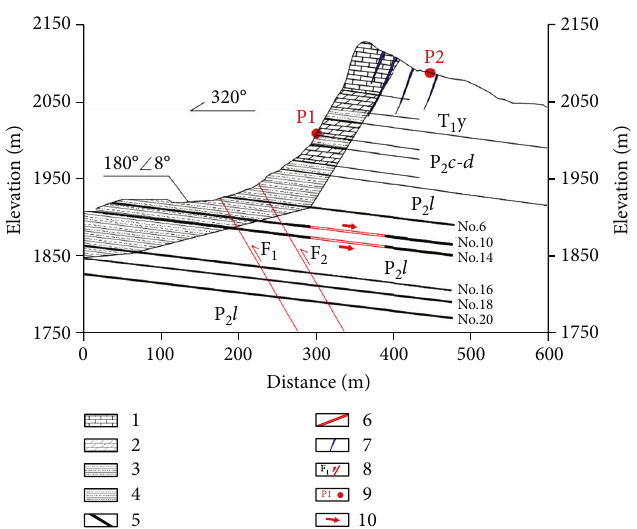
Figure 1: Prelandslide longitudinal pro fi le (1-1 ′ in Figure 4): (1) limestone; (2) marlstone; (3) siltstone; (4) mudstone; (5) coal seam; (6) goaf area; (7) tensile fi ssure; (8) fault; (9) InSAR monitoring point; (10) mining direction.